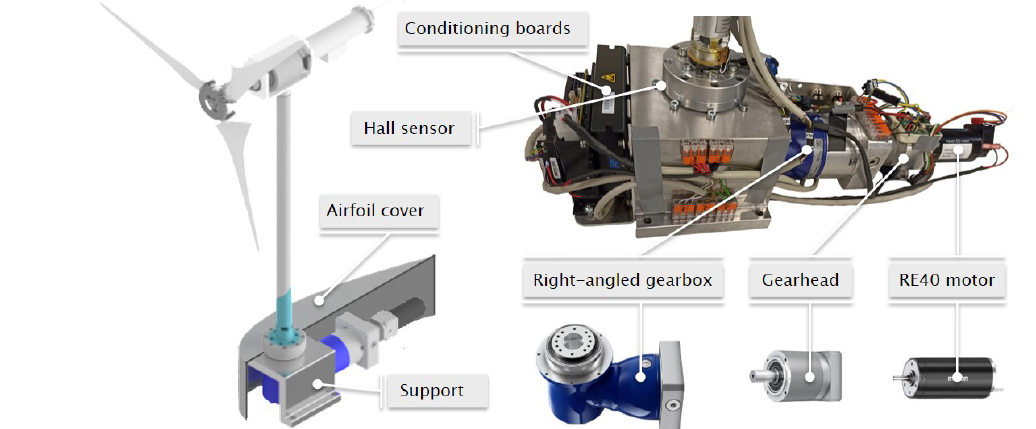
Figure 4. Yaw actuation system with its main